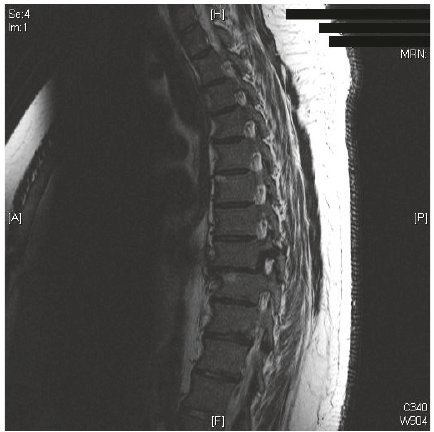
Figure1:MRIofthethoracicspineonpresentationtotheED,show- ing rupture of the ligamentum flavum at T7/8 and a hyperintense signal in the intervertebral disc at T8/9.